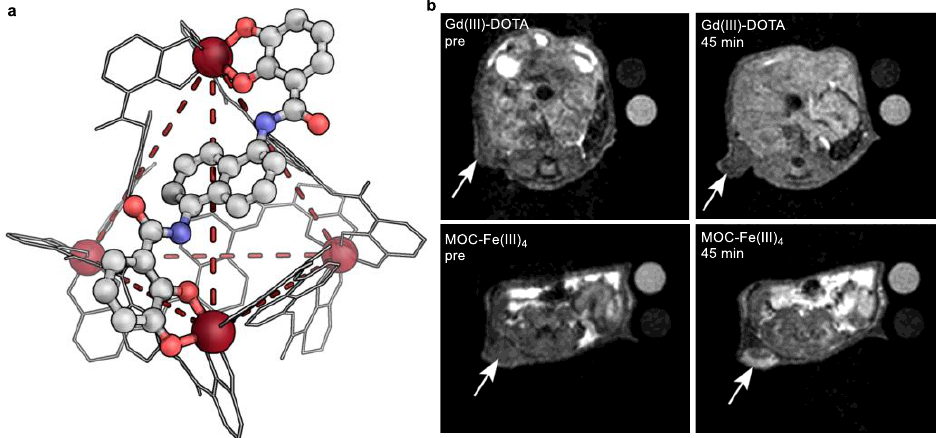
Figure 12. ( a ) SC-XRD model of MOC–Fe(III) 4 superimposed over a tetrahedron (red dashes). H atoms, counter-ions, and solvent were removed for clarity, ( b ) in vivo magnetic resonance images of subcutaneous ID8 ovarian cancer tumors before and after injection of Gd(III)–DOTA (50 µ mol/kg) or MOC–Fe(III) 4 (12.5 µ mol/kg). The arrows indicate the tumor regions [70]. Reprinted/adapted with permission from Ref. [70]. Copyright 2022 American Chemical Society. Table 3. Relaxivity ( r 1 , r 2 ) for multinuclear Fe(III) complexes. Complex